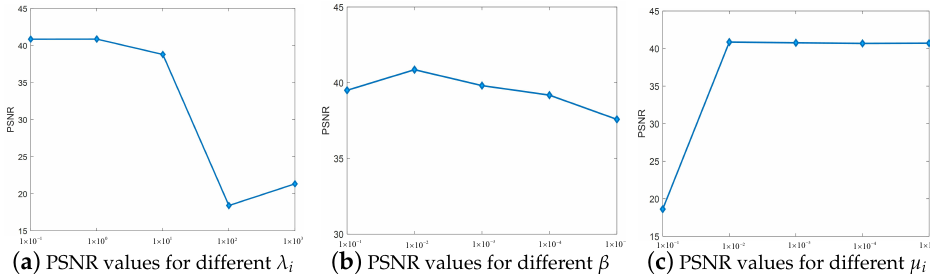
Figure 5. ( a – c ) PSNR values for the Pavia University dataset for the variation of parameters λ i , µ i , and β